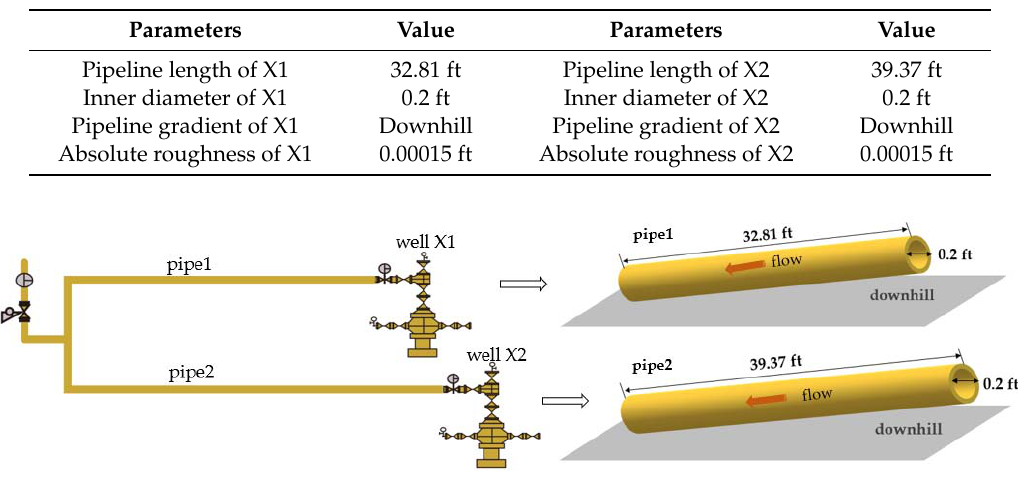
Table 1. The properties of the pipes and the measured data.